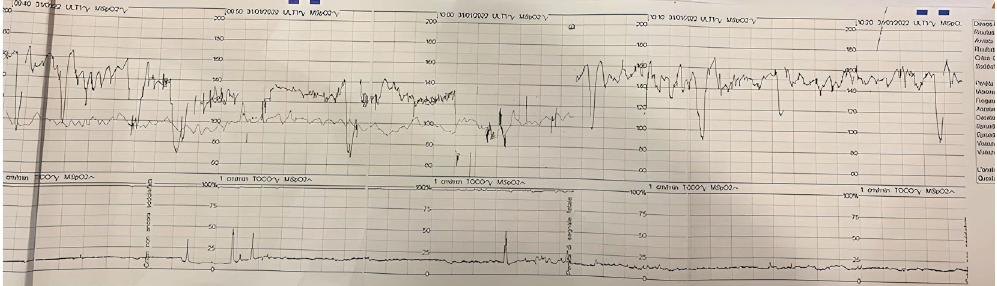
Figure 1: Cardiotocography at admission.